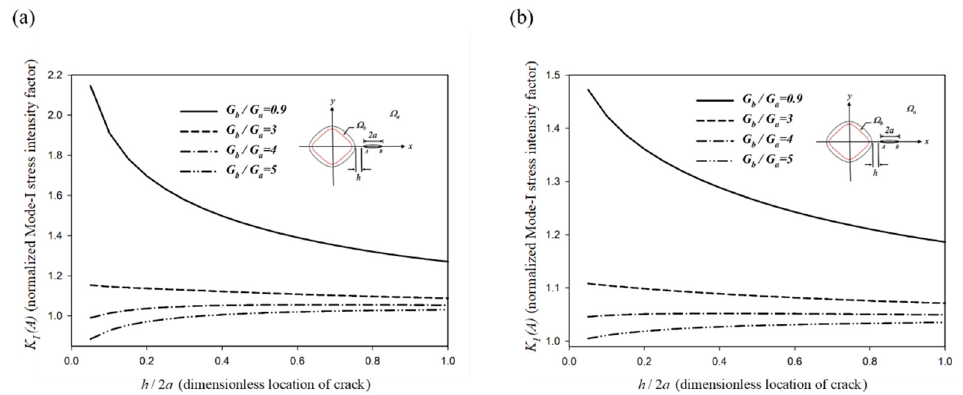
Figure 9. The SIFs with different shear moduli of an approximately square hole with inclusion layer ( a ) at Tip A ( b ) at Tip B ( r = 1.05, w = 0.06).